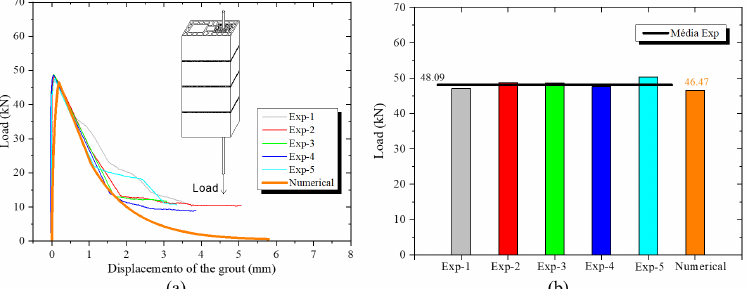
Figure 12. Validation of numerical results of the ClG14S12 series of pull-out tests: (a) force vs displacement diagrams and (b) mean maximum